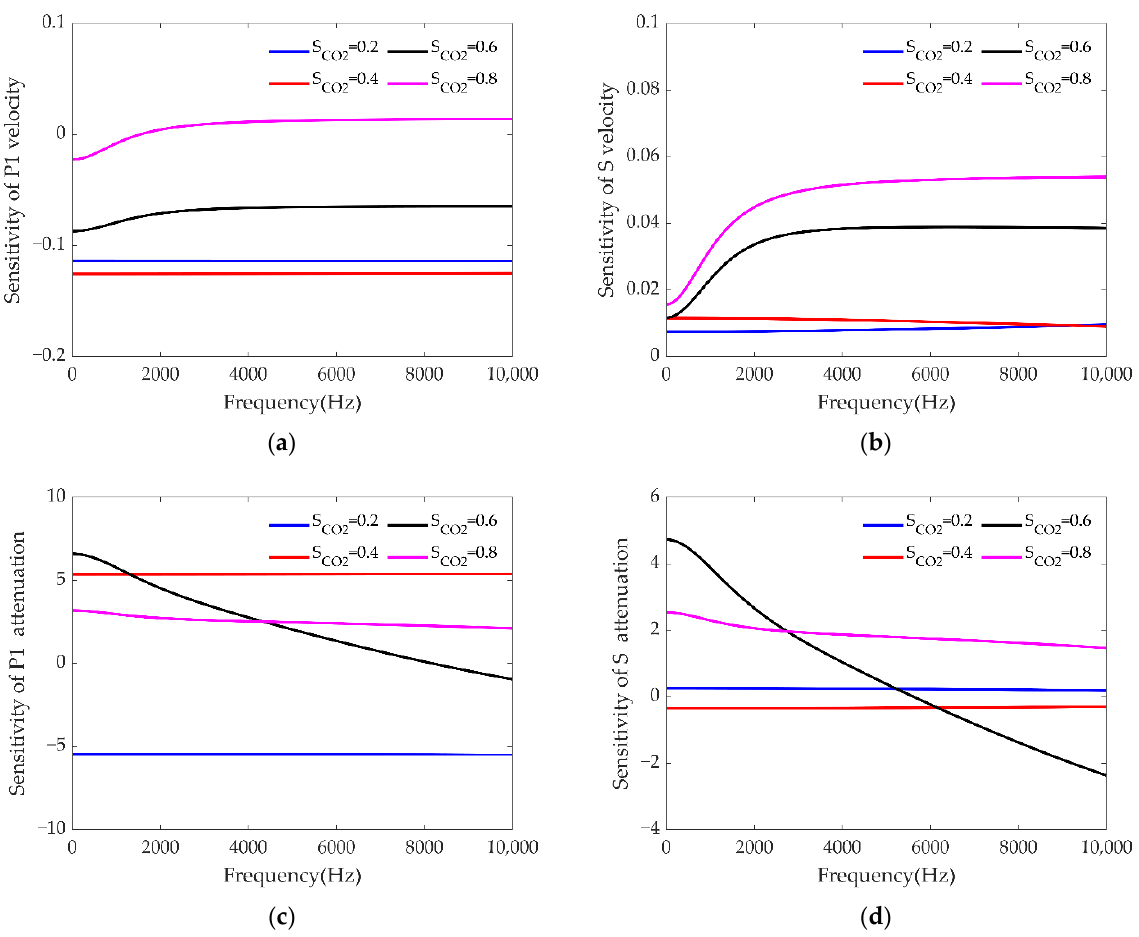
Figure 5. The sensitivities of velocities of P1 and S to CO 2 saturation, CO 2 saturation of 0.2, 0.4, 0.6, 0.8 are considered: ( a ) P1 velocity; ( b ) S velocity; ( c ) P1 attenuation; ( d ) S attenuation.